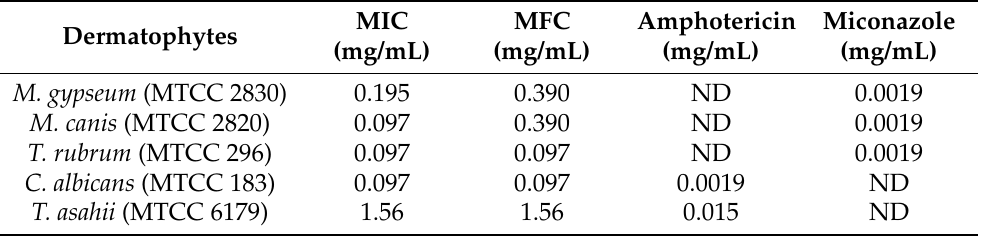
Table 3. Effect of TCAF2 evaluated against dermatophytes and yeast-like fungi assessed by minimum inhibitory concentration and fungicidal